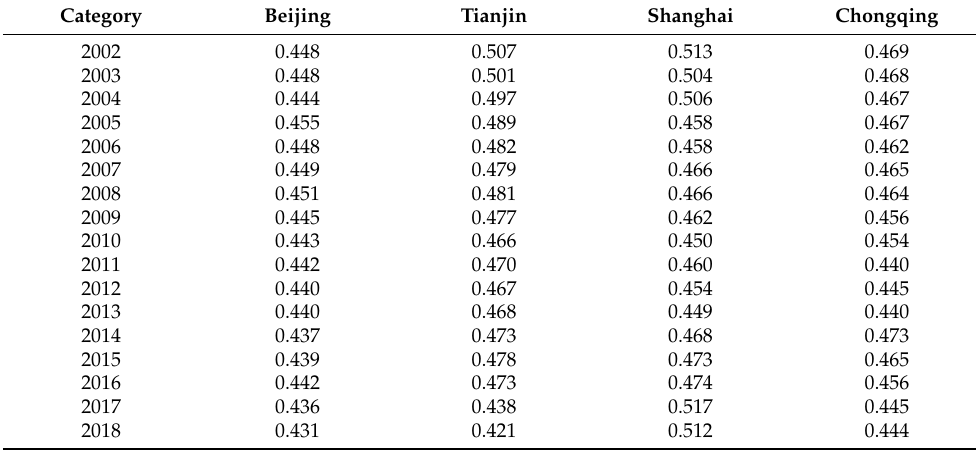
Table A2. Scores in pressure resiliencelevels from 2002 to